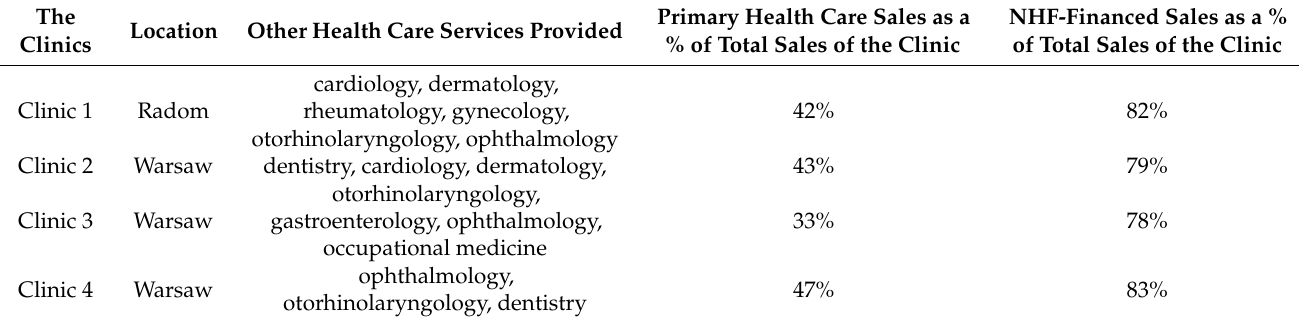
Table 2. The description of selected to the case studies primary health care services